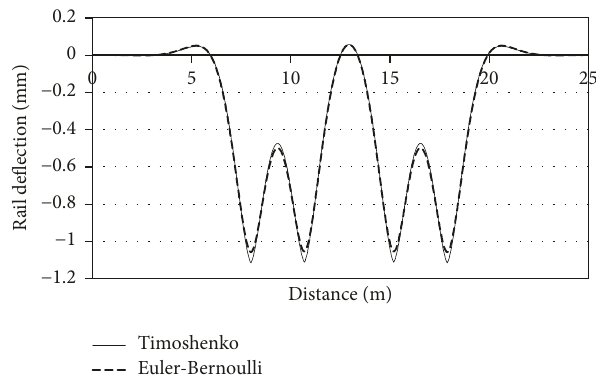
Figure 6: Rail deflection line for V = 0 km/h and for two types of models: the Euler-Bernoulli and the Timoshenko beams.